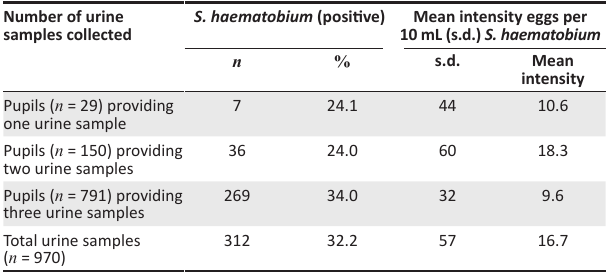
TABLE 3: Mean intensity (eggs per gram) of Schistosoma haematobium , Ascaris lumbricoides and Trichuris trichiura amongst pupils attending 18 KwaZulu-Natal primary schools.